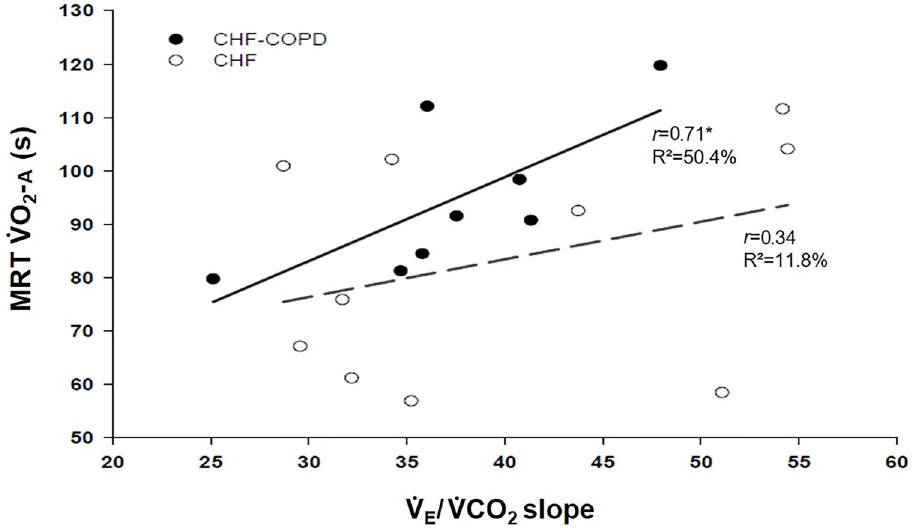
. . V E / VCO 2 ) slope and mean response time (MRT) of oxygen uptake